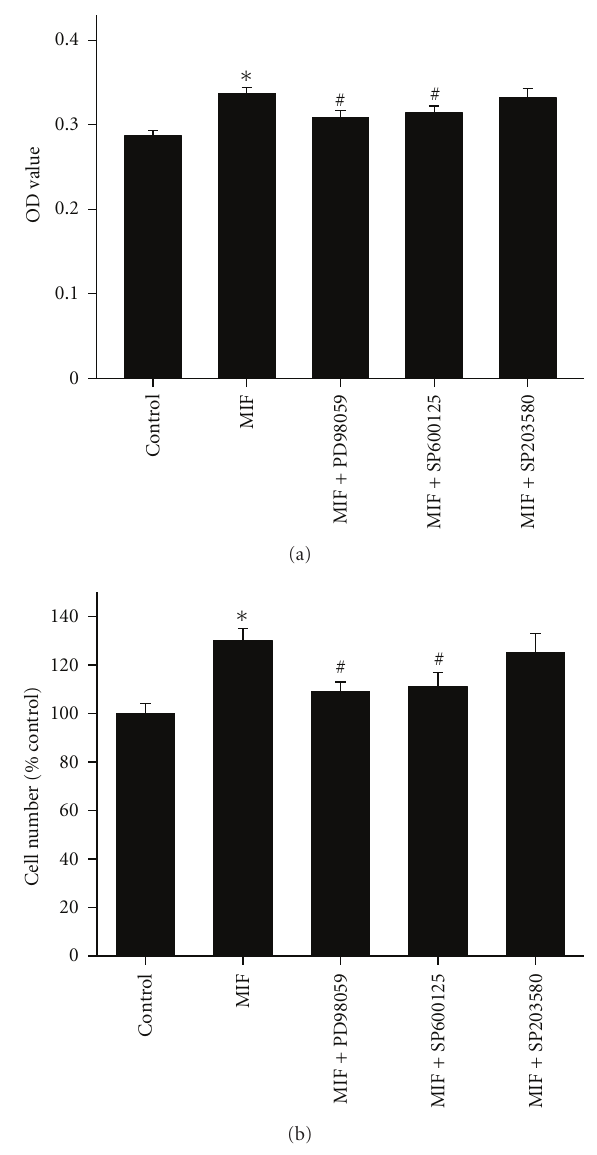
Figure 5: MIF-induced rat PASMCs proliferation is dependent on ERK1/2 and JNK activation. Cell proliferation was demonstrated by MTT (a) and direct cell counting (b). PASMCs proliferation stimulated by MIF (100ng/mL) was blocked by the MEK inhibitor (PD 98059, 20 μ M) and JNK inhibitor (SP 600125, 20 μ M), whereas the p38 MAPK inhibitor (SB 203580, 20 μ M) had no e ff ect. n = 8. ∗ P < 0 . 05 versus vehicle-treated control; # P < 0 . 05 versus groups treated with MIF